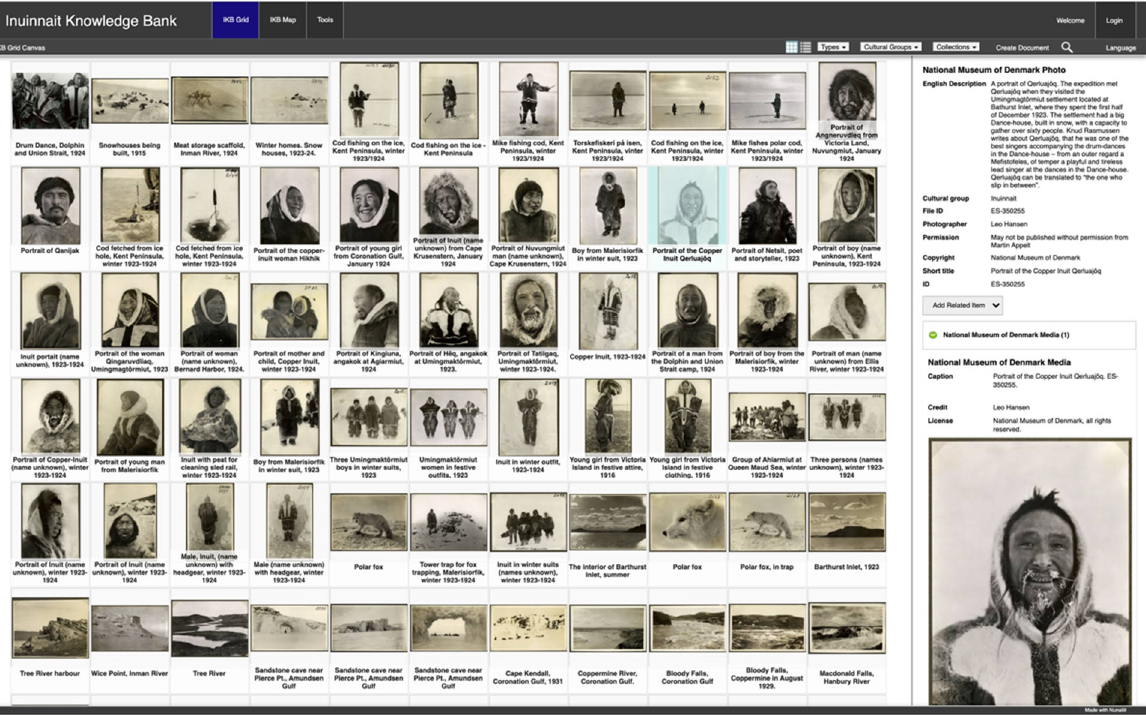
Figure 8. An overview of the records contained in the Inuinnait Knowledge Bank’s collection management system. Institutional metadata for each record are displayed verbatim on the right ‐ hand side of the screen.